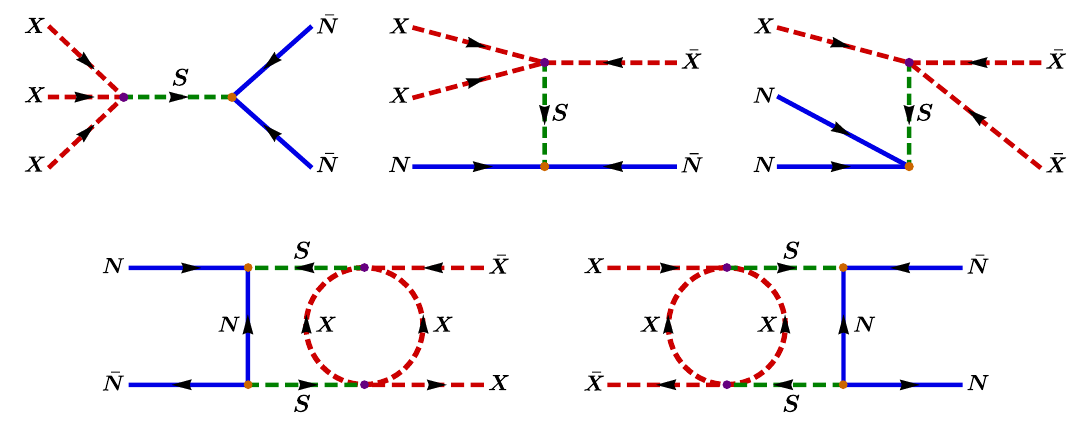
Figure 2 . The Feynman diagrams of the 3 → 2 and 2 → 2 processes in the r SIMP model, where the arrows represent the direction of dark charge